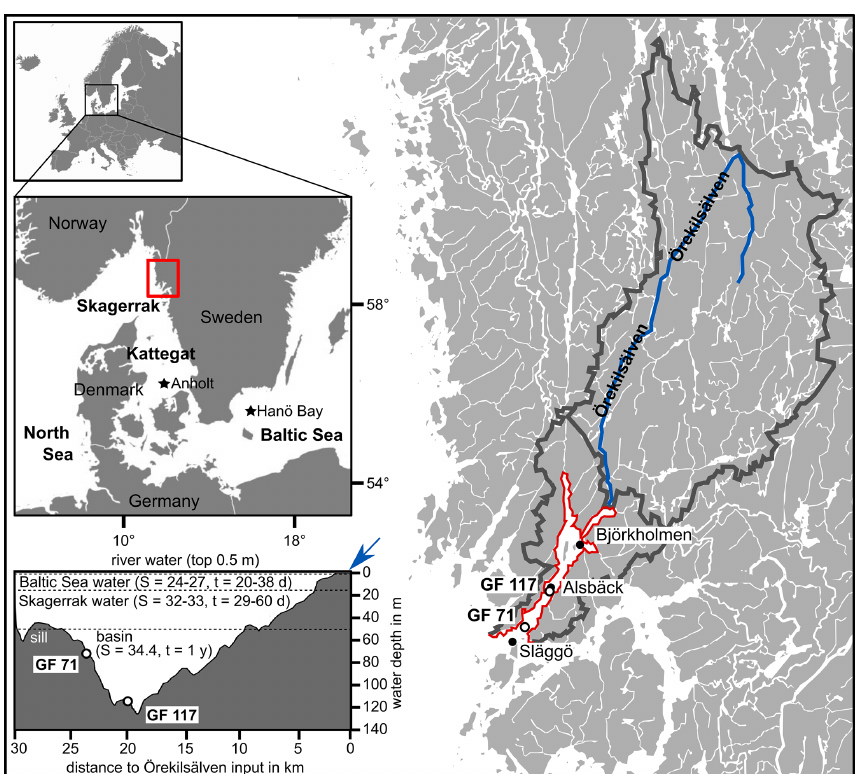
Figure 1. Location of the study area within Europe and on the west coast of Sweden (marked by red rectangle) giving an overview of Gullmar Fjord and Örekilsälven, including cumulative catchment area (outlined in dark grey). The study sites GF 71 and GF 117, and environmental monitoring sites Alsbäck, Björkholmen, and Släggö are indicated. A transect of Gullmar Fjord with water masses of different sources is given ( S = salinity, t = typical residence time in days (d) or years (yr); after Arneborg, 2004), with indication of Örekilsälven input (blue arrow). Maps modified after SMHI and Groeneveld et al.